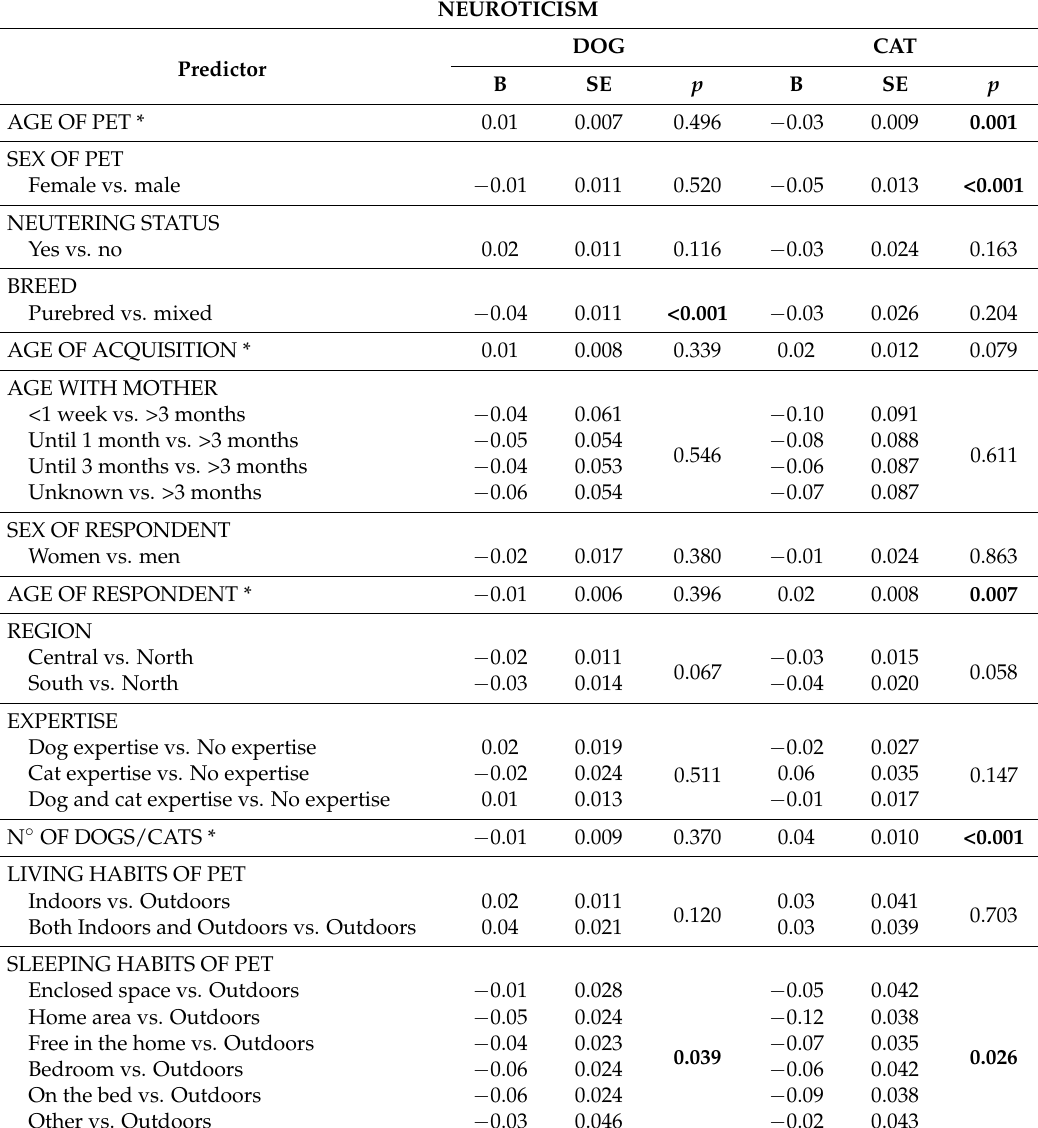
Table 5. Multivariate regression analysis for neuroticism in dogs and cats living in the same